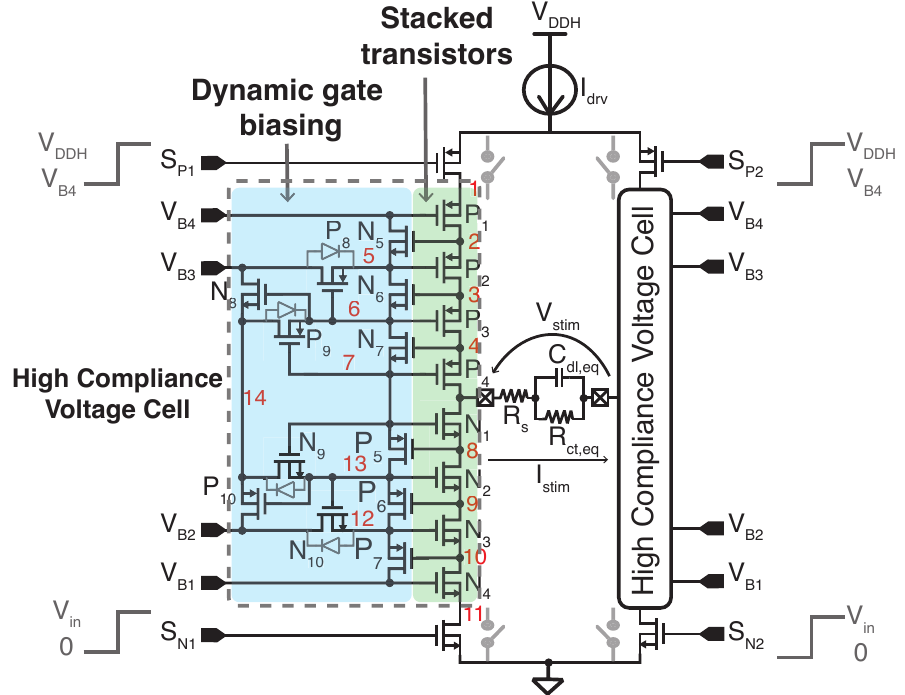
Figure 6. Proposed high-voltage-tolerant H-bridge, including the